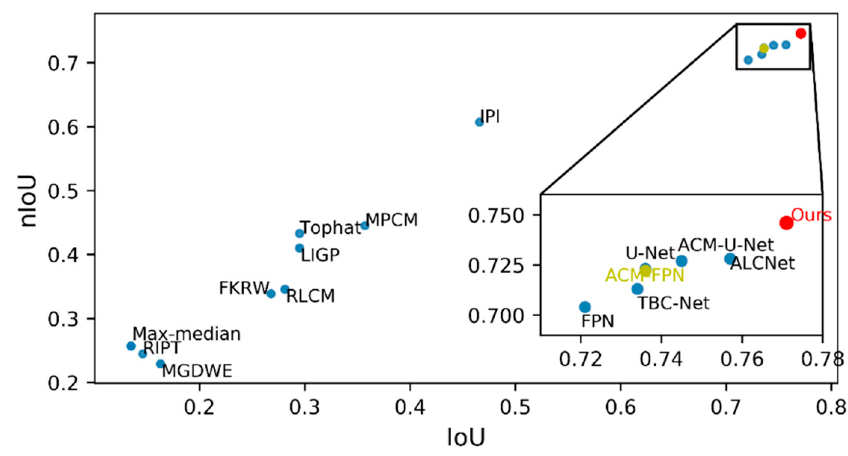
Figure 4. Inference IoU and nIoU comparison on the SIRST dataset.